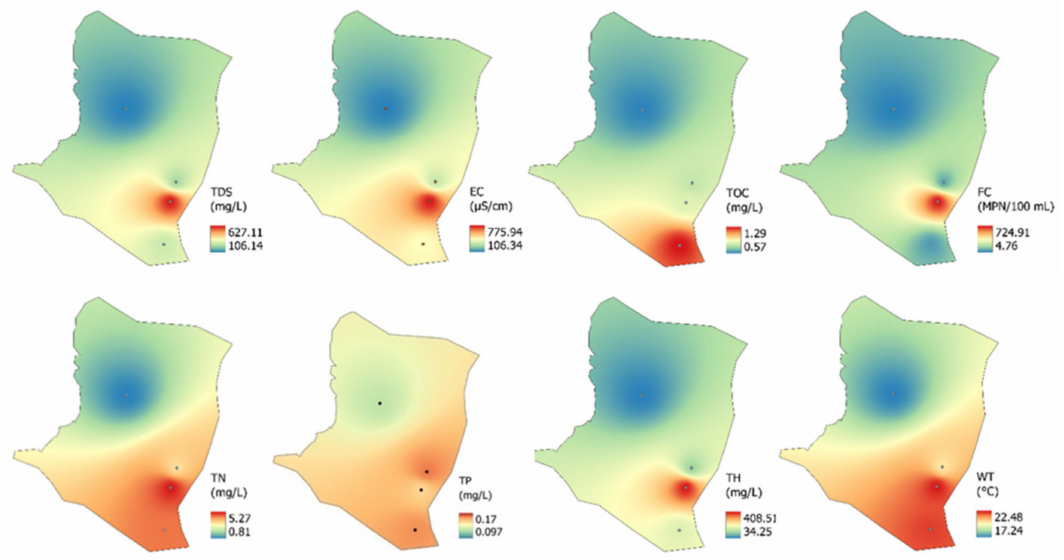
Figure 5. Spatial behavior of physicochemical parameters in the Cuernavaca